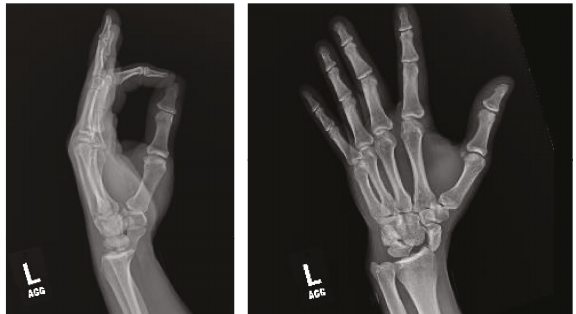
Figure 2: Postoperative radiographs.